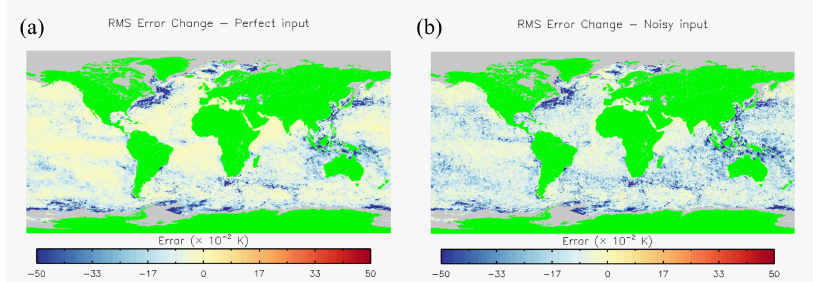
Figure 8. Change in the RMS error of the reconstructed SST field in January from adding CIMR data to the input for: ( a ) perfect input data and ( b ) input data containing realistic errors.